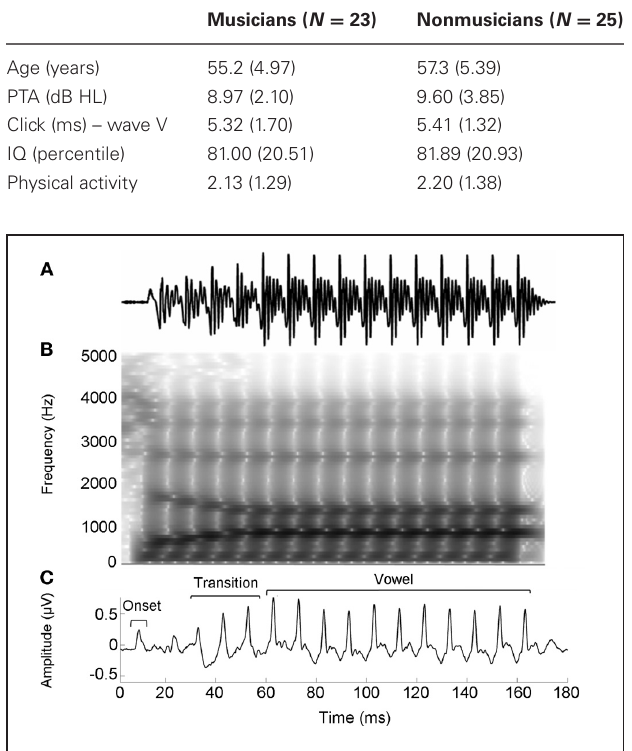
FIGURE 1 | Stimulus waveform (A), spectrogram (B), and group average response (C) for the speech syllable /da/. The group average response plotted is the older musician response in quiet.